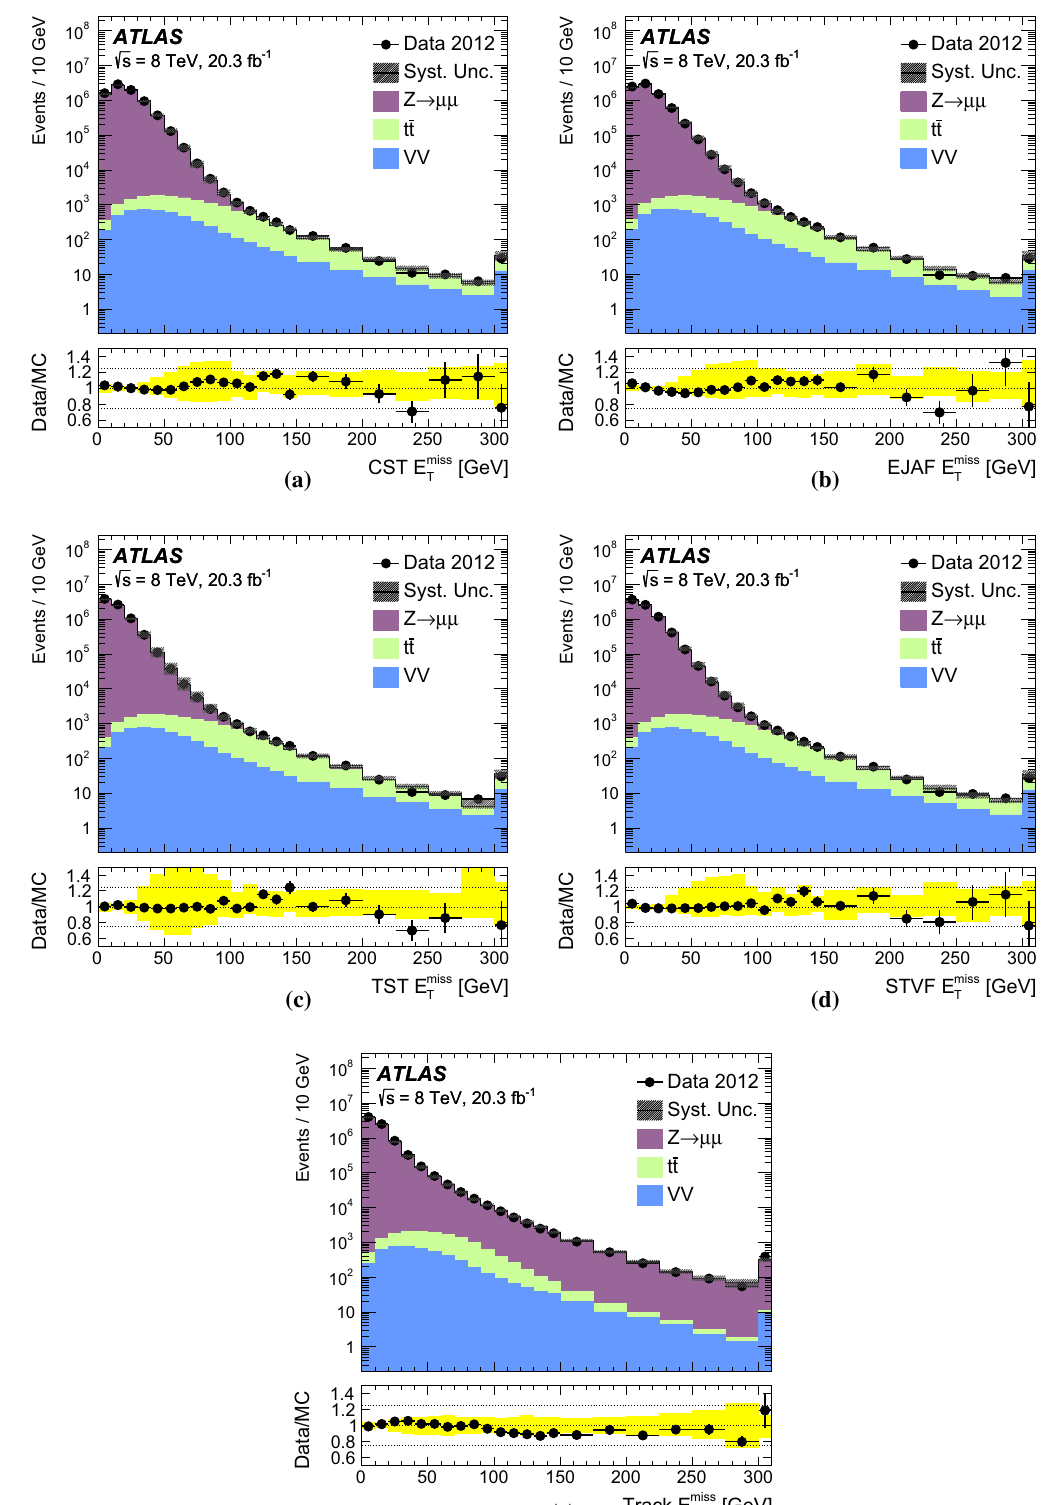
Fig. 3 Distributions of the E miss with the a CST, b EJAF, c TST, d T STVF, and e Track E miss are shown in data and MC simulation events T satisfying the Z → μμ selection. The lower panel of the figures shows